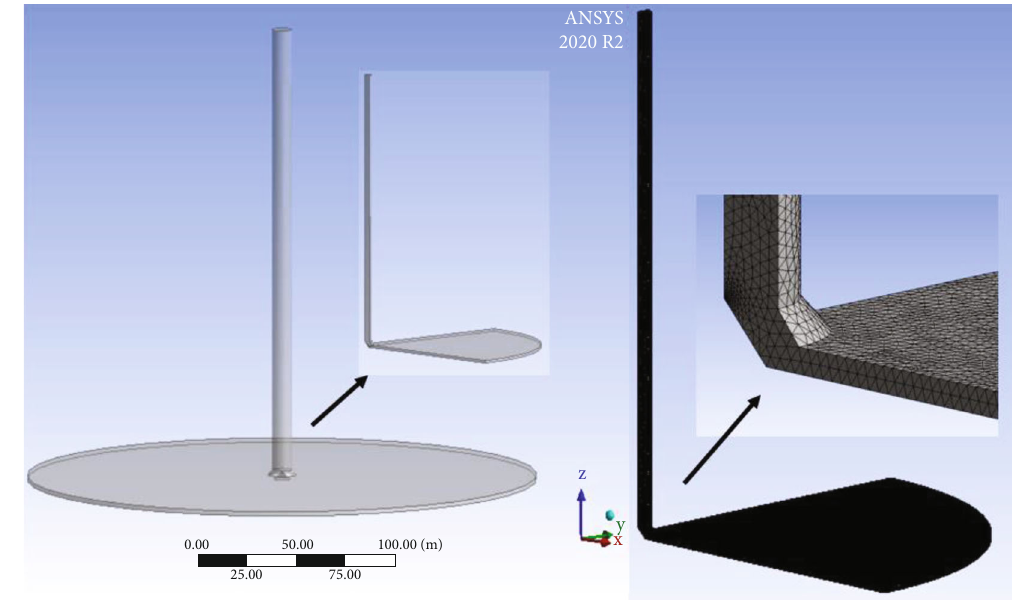
Figure 3: Model and mesh visuals.